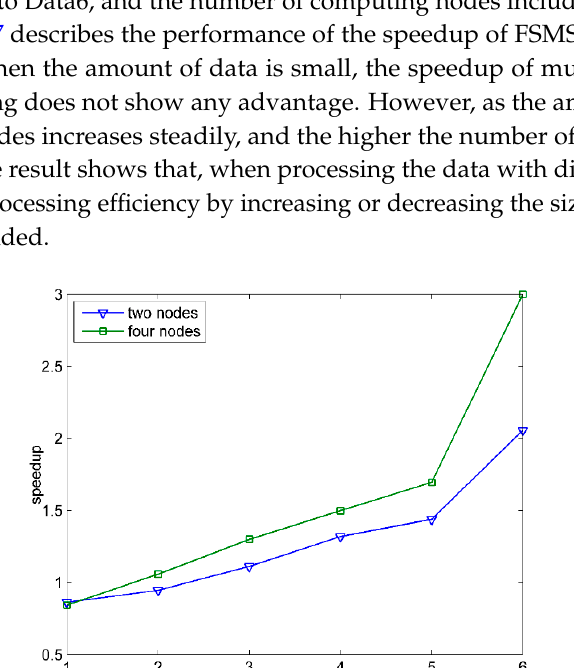
Figure 7. Speedup. Figure 7.